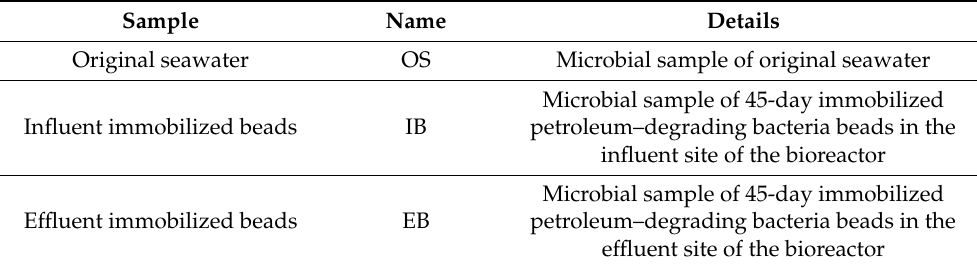
Table 1. Details for the